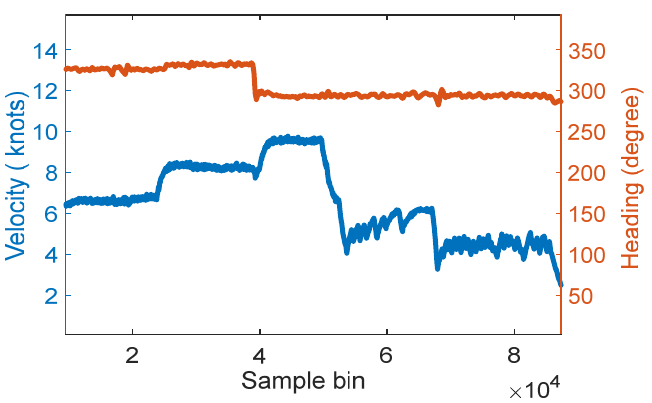
Figure 24. Location of coast-based radar station and navigation route of the ship.